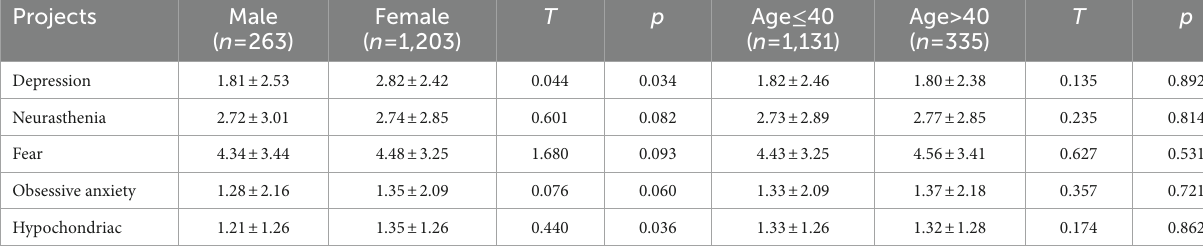
Each value represents the mean of four replicates ± standard deviation